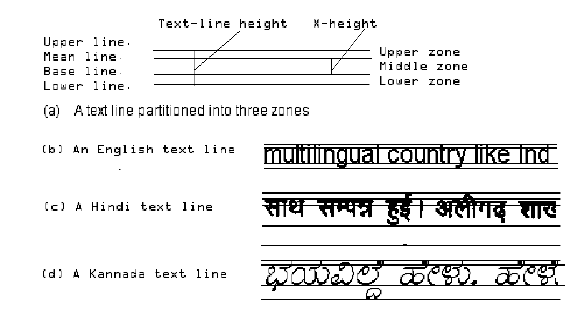
Figure 1. Partitioned text lines of English, Hindi and